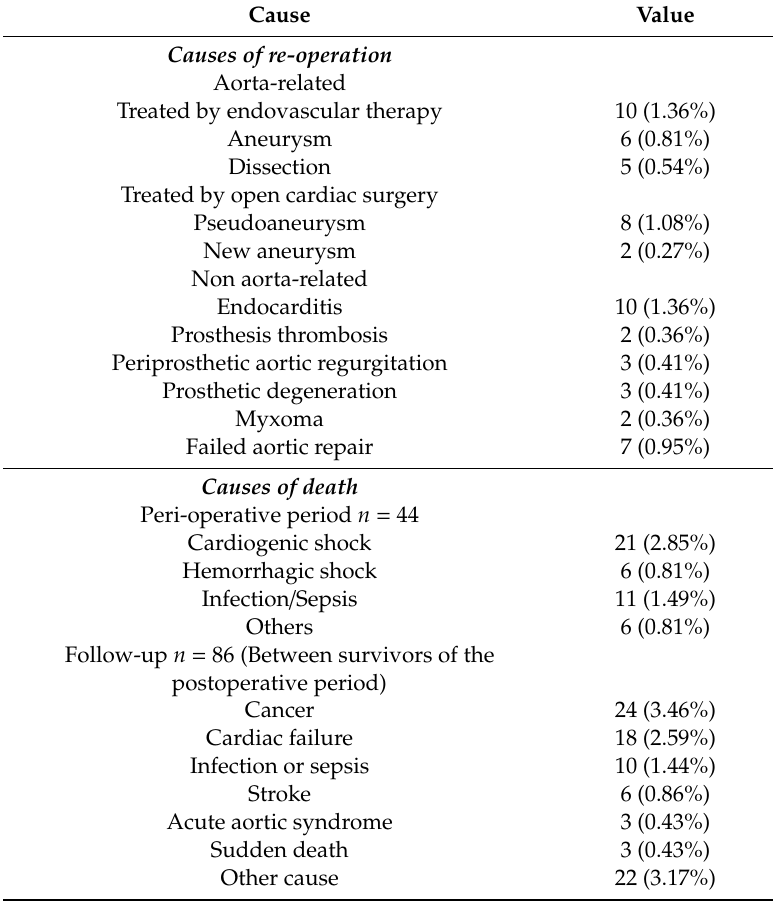
Table 3. Causes of re-operation and death.